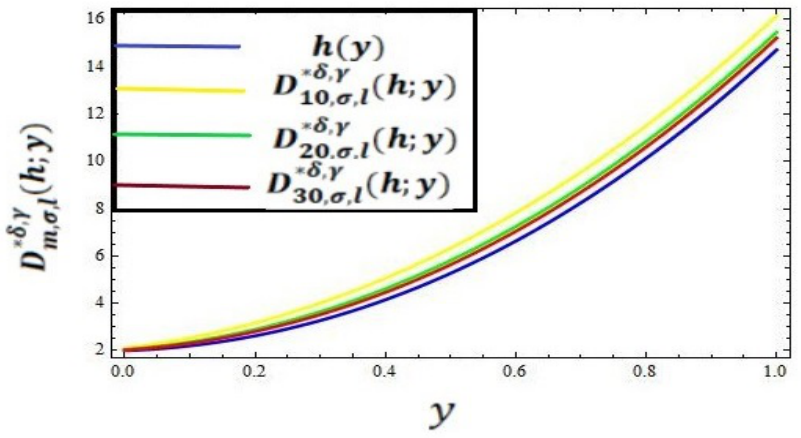
Figure 1. Graphical approximation representation of D ∗ δ , γ